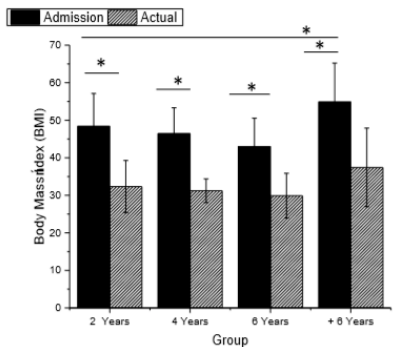
Figure 4. Body mass index in the different groups ( p < 0.001, f2 of Cohen = 0438).